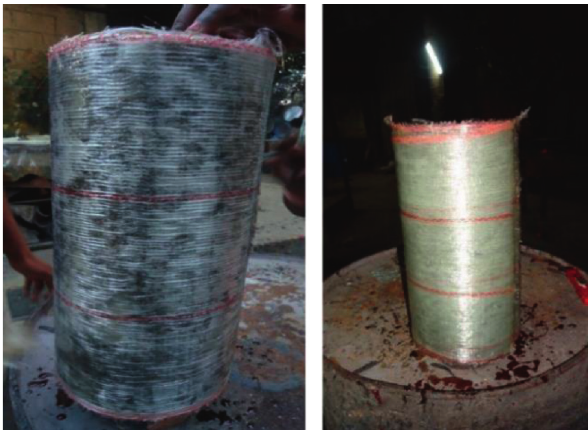
Figure 9: GFRP-wrapped columns.